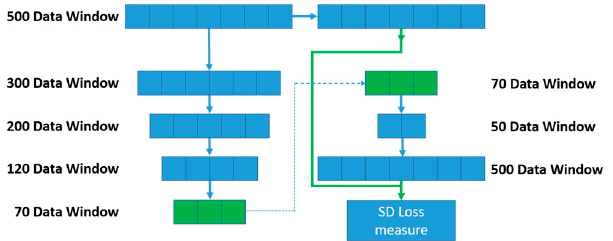
Figure 6. Overview of Model 5, to show the architecture of the model, and how the model evaluates the feature space of 70–50–500, using the initial window of data. Only the model layers 70–50–500 are trained in the final model, this can be described as an artificial neural network.